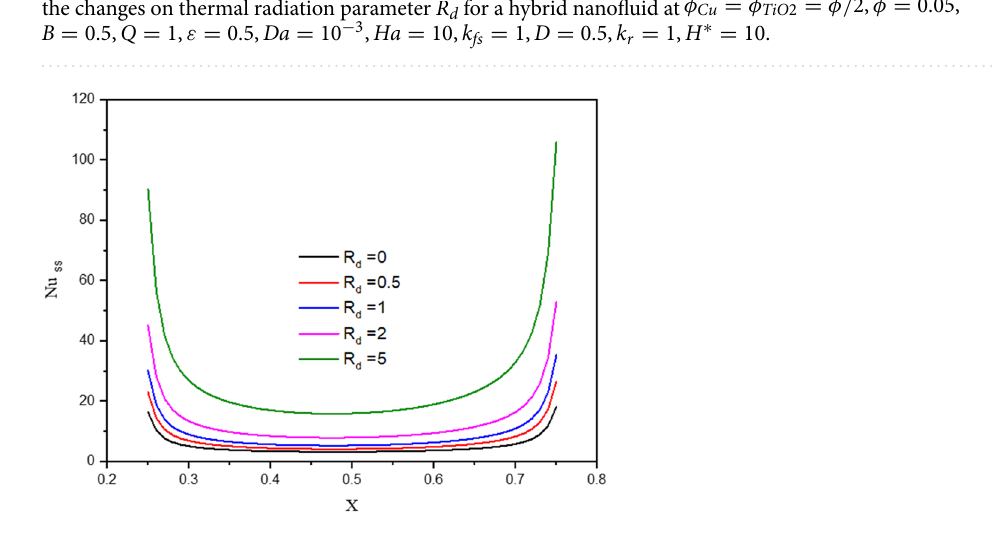
= φ = φ/ 2, φ = 0.05, TiO 2